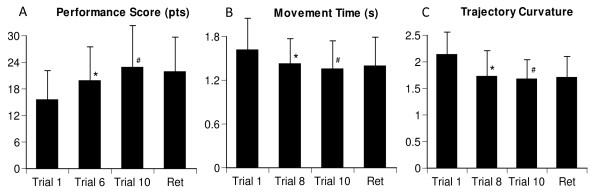
Means and standard deviations of the performance score (A), hand movement time (B), and trajectory curvature (C) during the first, middle, last, and retention trials. The middle trial is the trial when significant changes in presented parameter were observed. * identifies significant difference between the first trial and the trial where significant changes occurred; #- identifies significant difference between the first and the last trial.